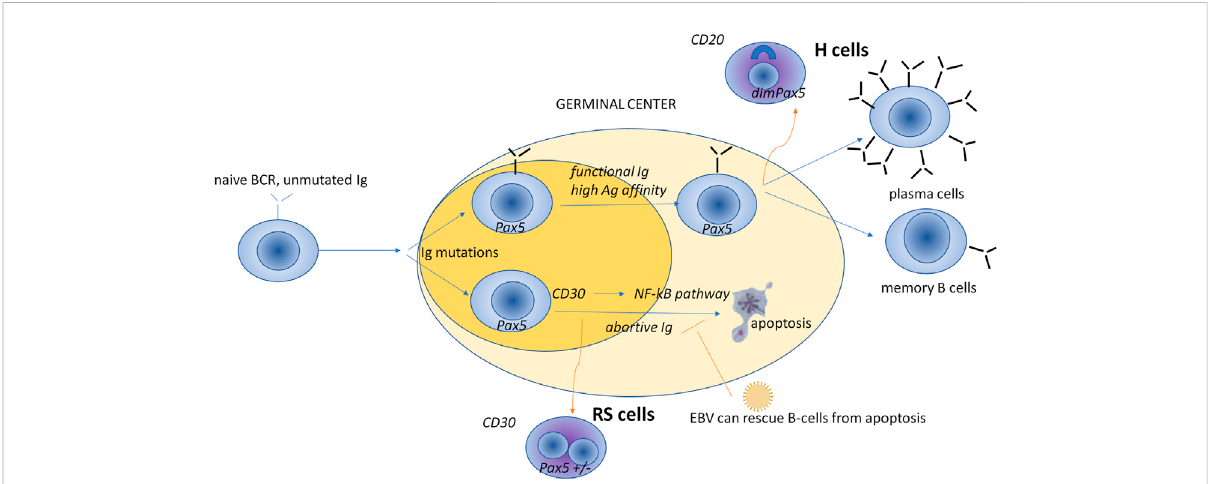
FIGURE 1 A model for the cellular germinal center origin of HRS cells. The origin of HRS cells has long been a matter of debate. Since the detection of clonal rearrangements of the immunoglobulin V gene in isolated HRS cells, it is now accepted that clonal B lymphocytes originate from HRS cells, with only a small proportion deriving from T lymphocytes. That said, HRS cells lose B-cell-speci fi c genes (e.g., immunoglobulin genes and genes involved in the antigen presentation by MHC) and show characteristic positivity for nuclear paired box protein 5 (PAX5) (Khan et al., 2018) and CD30 antigen (Swerdlow et al., 2016; Weniger et al., 2018). PAX5 encodes a B-cell speci fi c activator protein, a transcription factor expressed in the earlybutnotinthelatestagesofB-celldifferentiation.B-cellactivationleadstotheexpressionofthemembranereceptorCD30,whichregulatesthe apoptotic NF-kB pathway, and thus controls the load of the B-cell population (Küppers, 2009), B-cell receptor; dim, moderate expression; Hodgkin cells (H cells) of nodular lymphocyte-predominant HL; Ig, immunoglobulins; Reed-Sternberg (RS) cells of